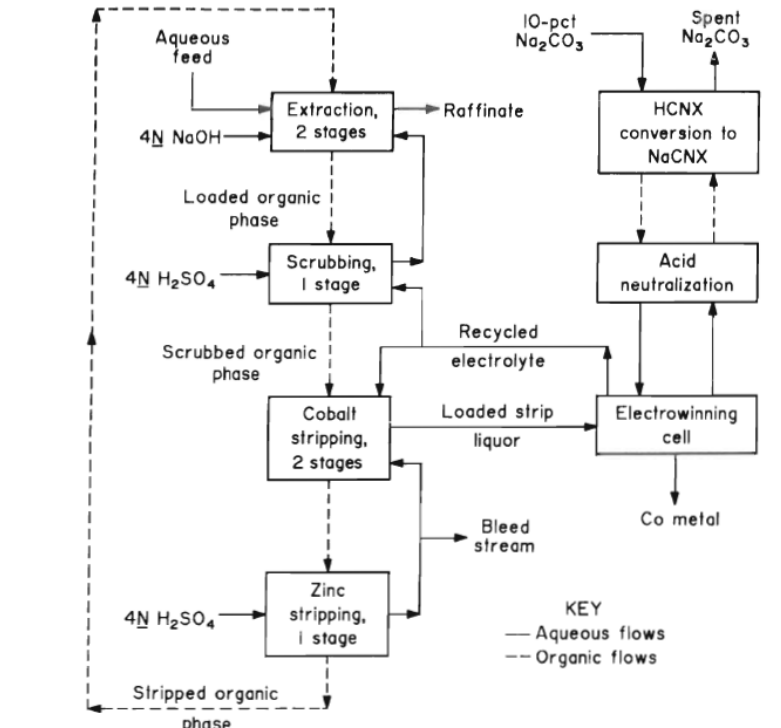
Figure 2 – Conceptual flow diagram for cobalt solvent extraction and electrowinning Рис . 2 – Концептуальная диаграмма экстракции кобальта в растворе